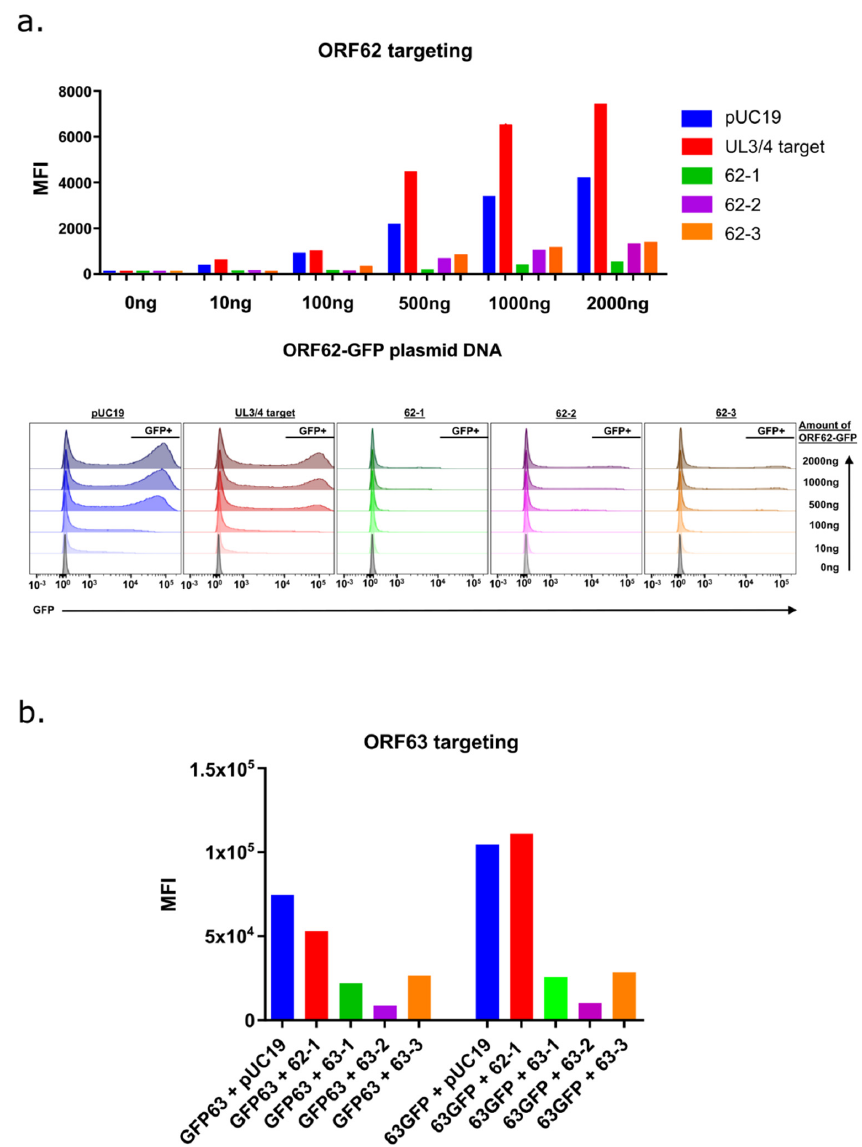
Figure 1. A preliminary study to evaluate ORF62- and ORF63-targeting gRNAs in pX601 to prevent gene expression. ( a ) HEK 293 cells in 6-well plates were transfected with a range (0–2000 ng) of CMV-ORF62-GFP plasmid, along with 2 μ g of plasmid pUC19; a pX330-based plasmid with a gRNA template derived from HSV UL3/4; or pX601 AAV plasmids containing the templates for ORF62 gRNAs 1–3, constructed as detailed in the Methods. To maintain the same level of DNA in each transfection, pUC19 was added. At 36 h post transfection, cells were harvested by trypsinization and analyzed by flow cytometry to determine the mean fluorescence intensity (MFI) for each treatment. ( b ) To determine the optimal gRNAs for targeting ORF63 in pX601, HEK293 cells in 6-wells were co-transfected with 500 ng of CMV-promoter-driven ORF63-GFP plasmid expressing a C-terminal tagged GFP (63GFP) or a similar plasmid-driving expression of N-terminal tagged GFP (GFP63); each with either 1500 ng of pUC19 DNA, the px601 containing the 62-1gR template, or one of three selected pX601 plasmids containing the ORF63-gR templates as detailed in Table 1. After 72 h, the cells were subject to flow cytometry and the MFI was determined using FlowJo software. The data represent the MFI of single transfections performed in parallel and were not statistically evaluated.